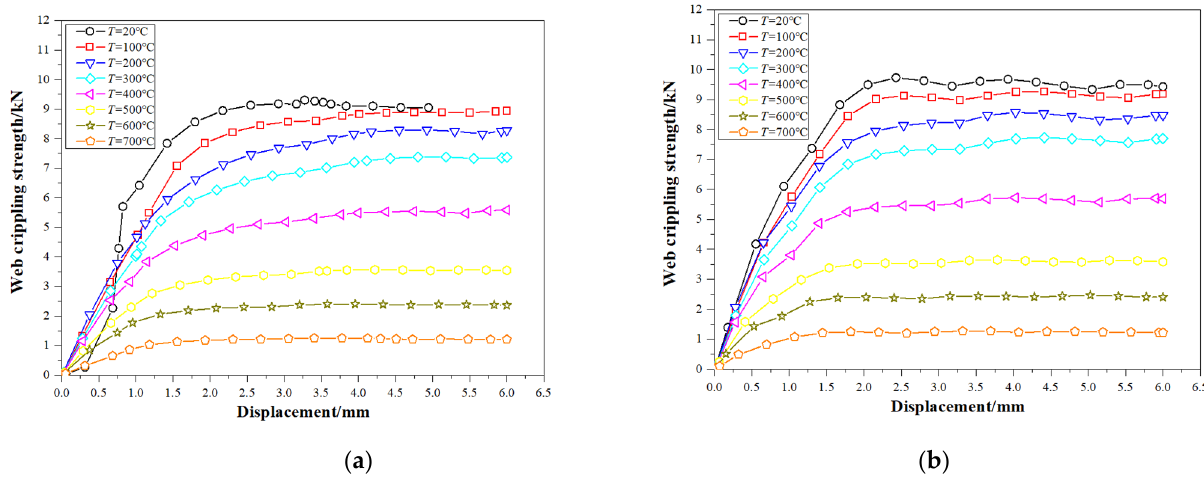
Figure 6. Load-displacement plot of selected sections under different temperatures for ( a ) unfastened section (100 × 30 × 15-t1.55-N50-A0.6-FR) with a centered hole and ( b ) fastened section (100 × 30 × 15-t1.55-N50-A0.6-FX) with a centered hole.